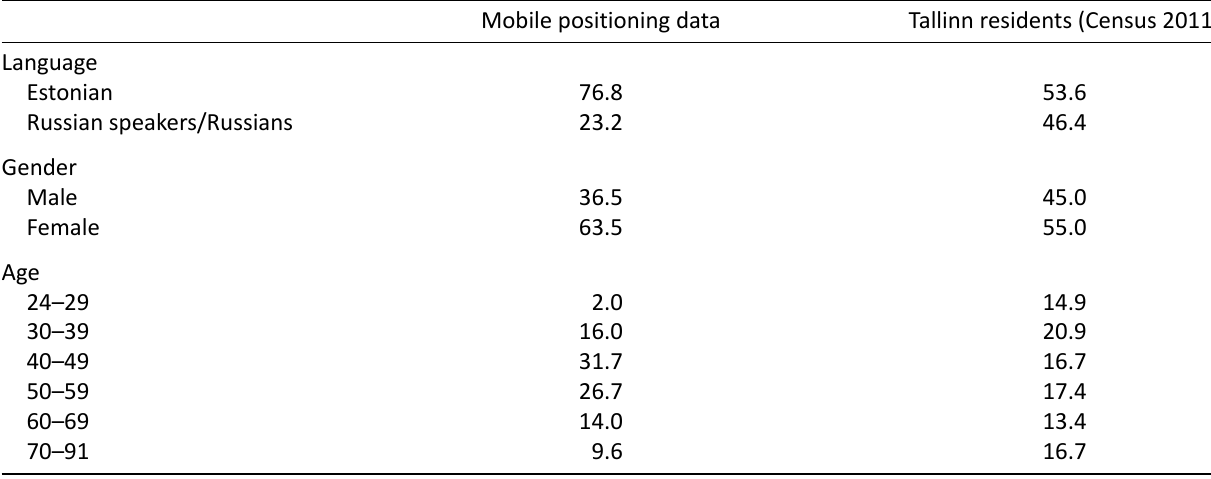
Table 1. Percentage distribution of characteristics of the sample compared with Tallinn residents based on 2011 census